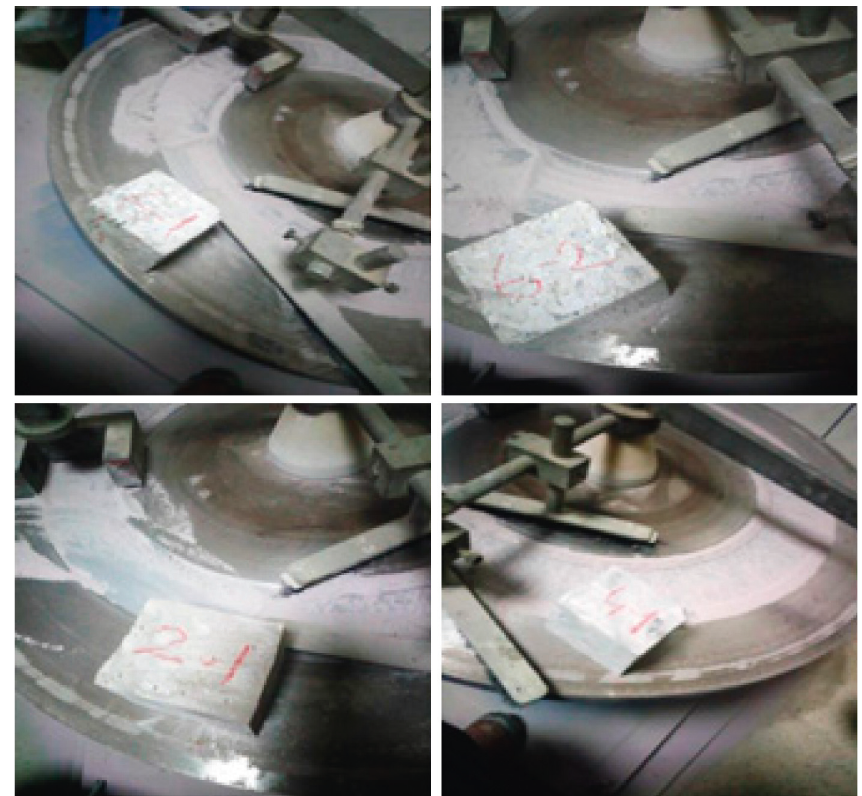
Figure 11: Abrasion test for RWC, RCC, ASWC, and MSWC interlocked paving stones.